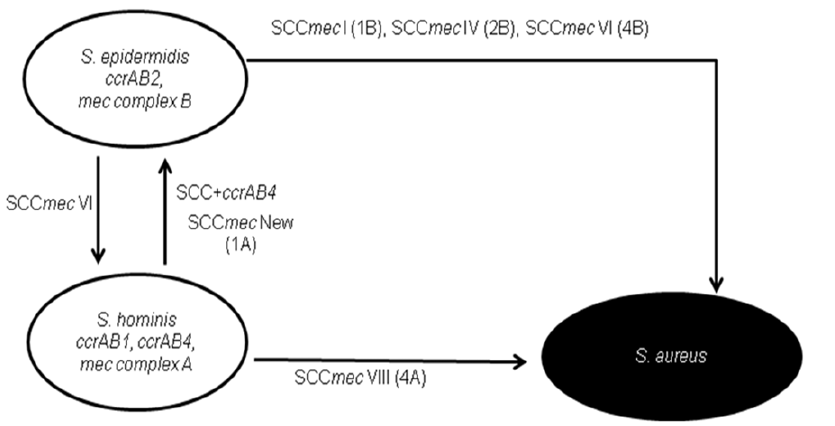
Figure 3. Model for the contribution of S.hominis species for SCC mec evolution, based on our data and data collected from the bibliography (see discussion). S. epidermidis is the primary reservoir of ccrAB2 , mec complex B, and probably was the species where SCC mec IV was assembled. S. hominis might have been the primary reservoir of ccrAB1 , ccrAB4, and mec complex A, and probably was the species where new SCC mec type 1A and SCC mec VIII were first assembled. SCC mec type VI probably resulted from the acquisition by S. epidermidis of a SCC non- mec carrying ccrAB4 genes from S. hominis . In S. epidermidis , this SCC non- mec probably received the mec complex B that is very frequent in this species and rare in S. hominis . According to this model S. epidermidis was the most probable donor of SCC mec I, IV, and VI, to S. aureus , whereas S. hominis was the most probable donor of SCC mec type VIII to S. aureus .